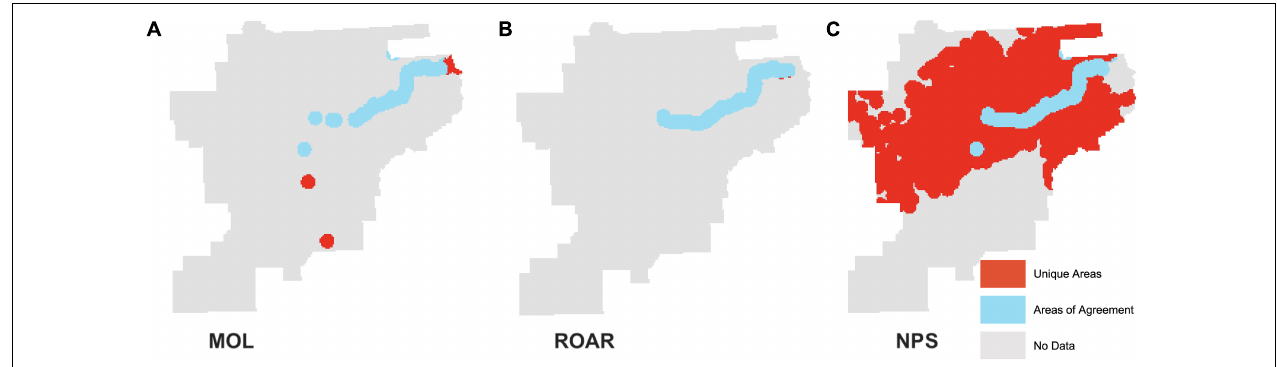
FIGURE 9 | Aptness component results for each dataset. Gray areas are where no datasets have data, blue are areas of agreement, and red areas are unique. (A,B) , and (C) show where each dataset is in the agreement with the others. (A) The MOL data; the areas in blue are where the MOL data are in agreement with the other two datasets and the areas in red show where the MOL data are unique and had observations where the other two datasets do not. (B) The ROAR data; the ROAR data are mostly in agreement with the other two datasets. (C) The NPS radio collar collected data and it is the dataset with the most unique points.